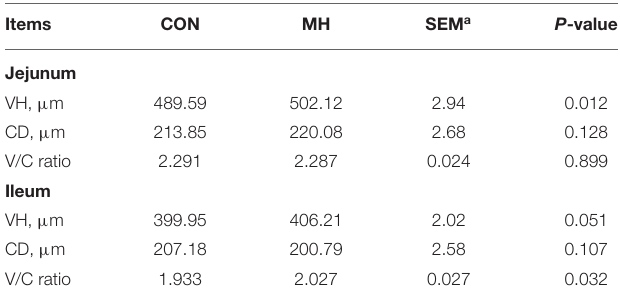
TABLE 5 | Effects of dietary moderate-high dose LM1 on intestinal morphology of growing pigs.